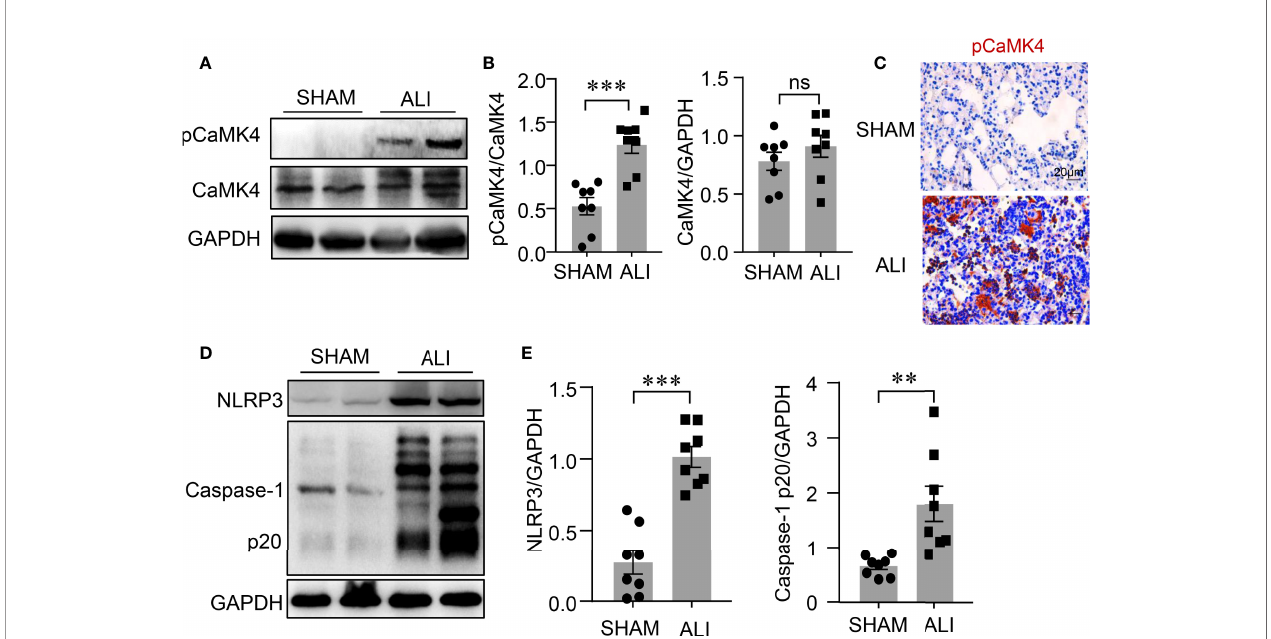
FIGURE 1 | Activation of CaMK4 and NLRP3 in fl ammasome in LPS-induced ALI. LPS (6mg/kg) was delivered to the lungs of the C57BL/6 mice and sham operated mice were given equal amount of PBS as control. Lung tissues were collected 2 days after mice treated with PBS (SHAM) or LPS (ALI). (A) Representative bands of immunoblotting showed p-CaMK4 and CaMK4 expression in lung tissues from PBS or LPS treated mice. (B) Relative expression of p-CaMK4 to CaMK4 was summarized from 8 mice. (C) Immunohistochemistry staining of pCaMK4 in lung tissues from PBS or LPS treated mice. Representative images were shown. Scale bar: 20 m m. (D) NLRP3, Caspase-1p20 and GAPDH in the lung tissues from mice treated with PBS or LPS were measured by Western blot. Representative bands were shown. (E) Relative expressions of NLRP3 and Caspase-1p20 to GAPDH were summarized. All data are mean ± SEM. **p < 0.01, ***p < 0.001. ns, not signi fi